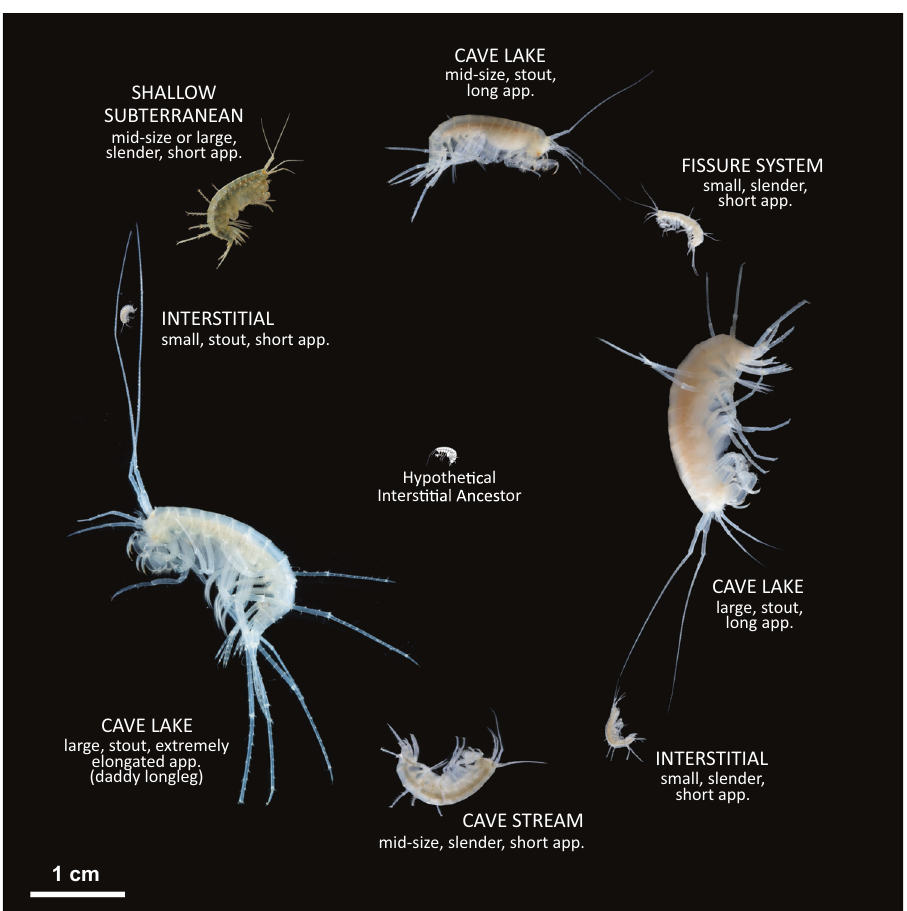
Fig. 1 Morphological and ecological diversity of Niphargus species. Adaptive radiation of Niphargus produced several morphotypes that inhabit distinct subterranean habitats and niches. Different-sized morphotypes can occur together in cave lakes, and differently shaped morphotypes can occur together in interstitial habitats 17 . These morphotypes evolved in at least fi ve adaptive radiation events from hypothetical small-bodied ancestors from the shallow interstitial habitat 20,23 . Appendages are abbreviated as app . Photographs used with author ’ s permission: Denis Copila ş -Ciocianu (shallow subterranean), Teo Deli ć (all